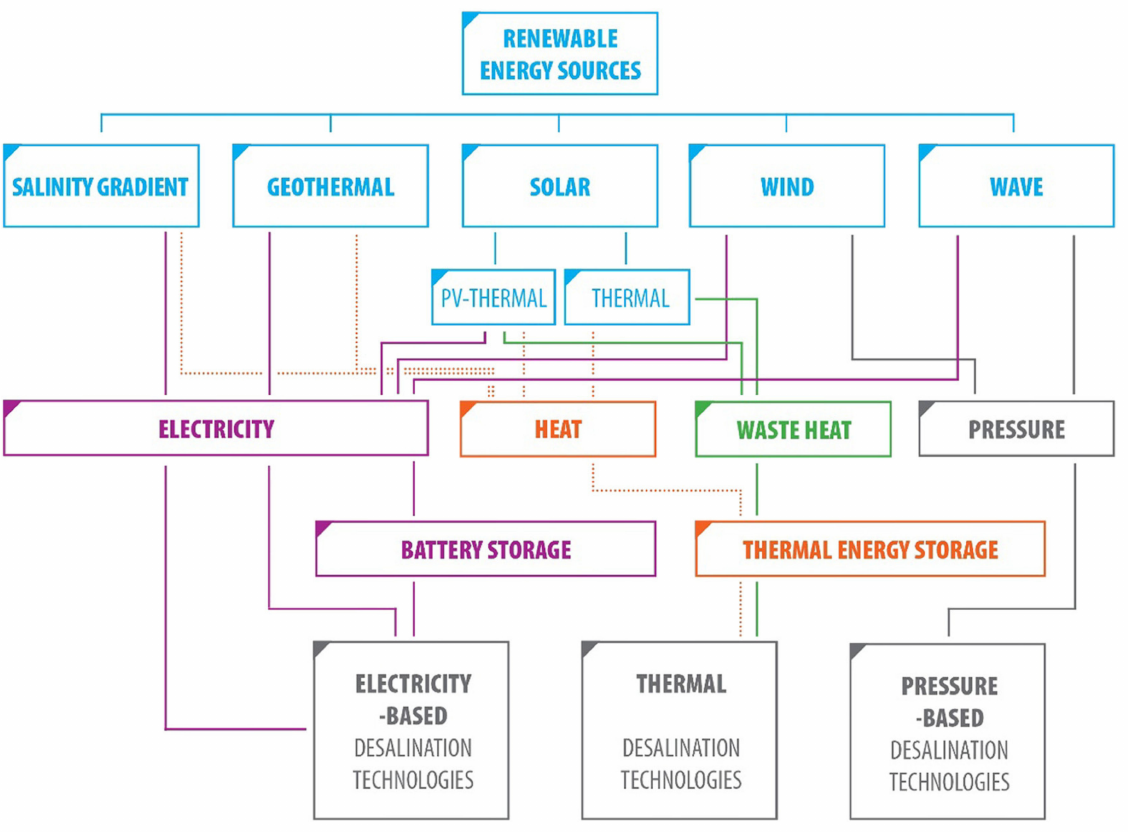
Figure 9. Energy storage in processes related to desalination technologies taken from